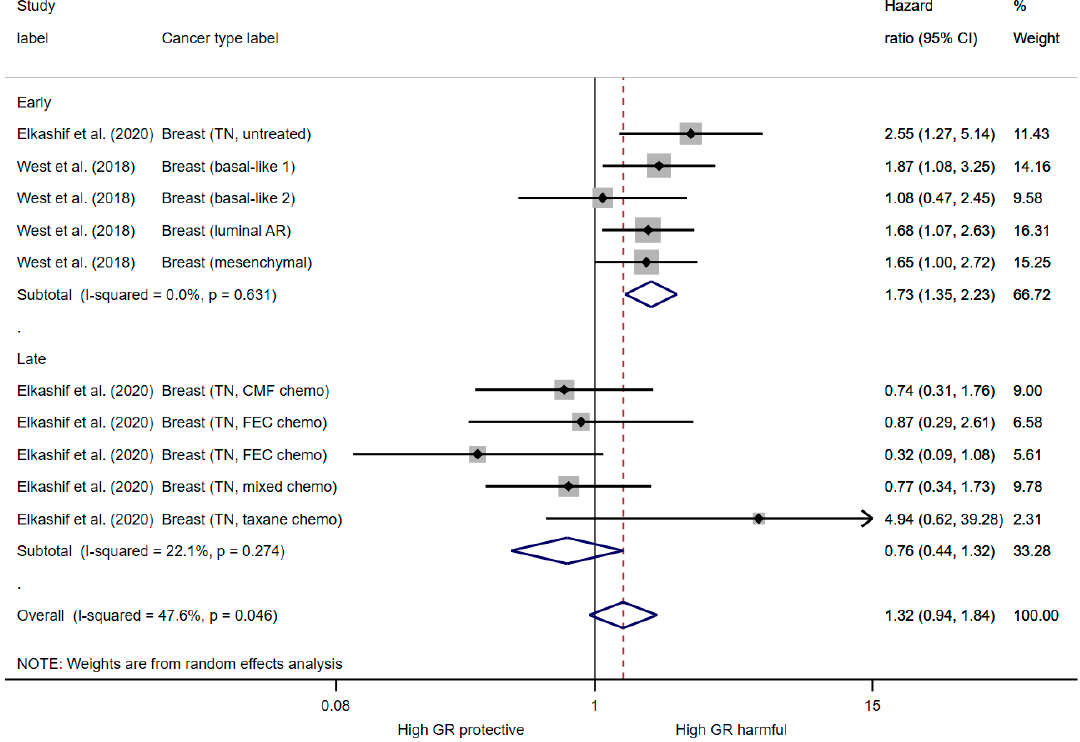
Figure 5. The forest plot for univariate progression free survival in the oestrogen negative breast cancer in early stage untreated ( n = 685) and late stage chemotherapy treated ( n = 278). The meta analysis was preformed using hazard ratio and 95% confidence intervals (random effects). The chi-squared ( χ 2) for heterogeneity was performed and the proportion of variance between effect estimates is represented by I 2 , with a level of >50% considered